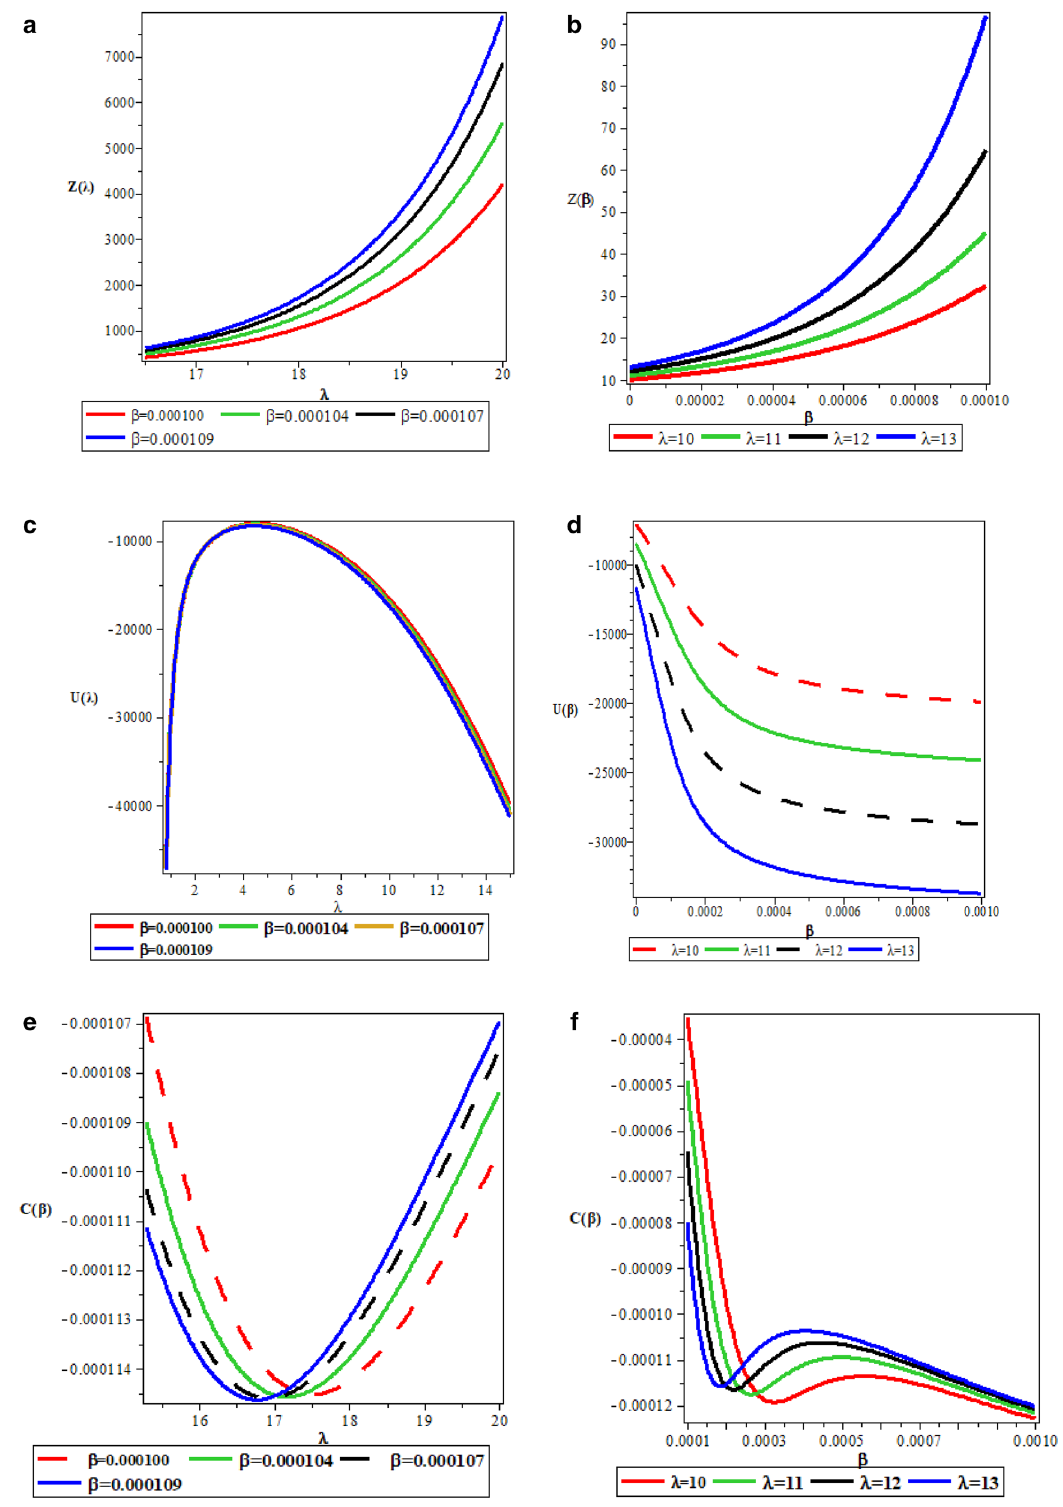
Figure 2. ( a ) Variation of partition function with respect to (cid:31) . ( b ) Variation of partition function with respect to β . ( c ) Variation of vibrational mean energy with respect to (cid:31) . ( d ) Variation of vibrational mean energy with respect to β . ( e ) Variation of specific heat capacity with respect to (cid:31) . ( f ) Variation of specific heat capacity with respect to β . ( g ) Variation of vibrational entropy with respect to (cid:31) . ( h ) Variation of vibrational entropy with respect to β . ( i ) Variation of vibrational free energy with respect to (cid:31) . ( j ) Variation of vibrational free energy with respect to β